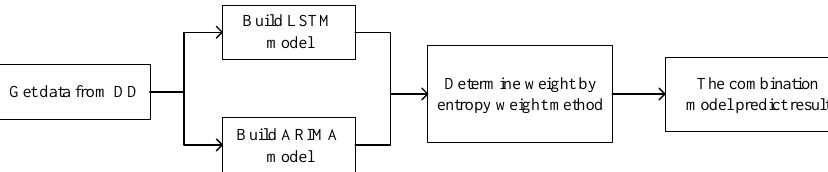
Figure 2. The process of combination model